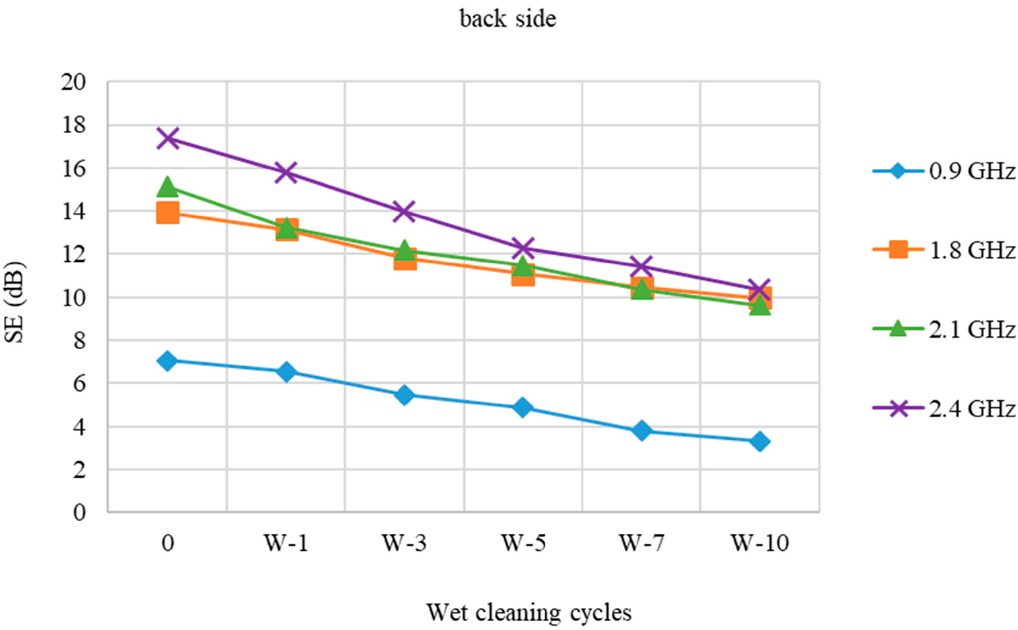
Figure 5. Shield effectiveness of PES/CO/SS fabric (back side) before and after 1st, 3rd, 5th, 7th, and 10th wet cleaning cycles (W) at frequencies 0.9 GHz, 1.8 GHz, 2.1 GHz, and 2.4 GHz.